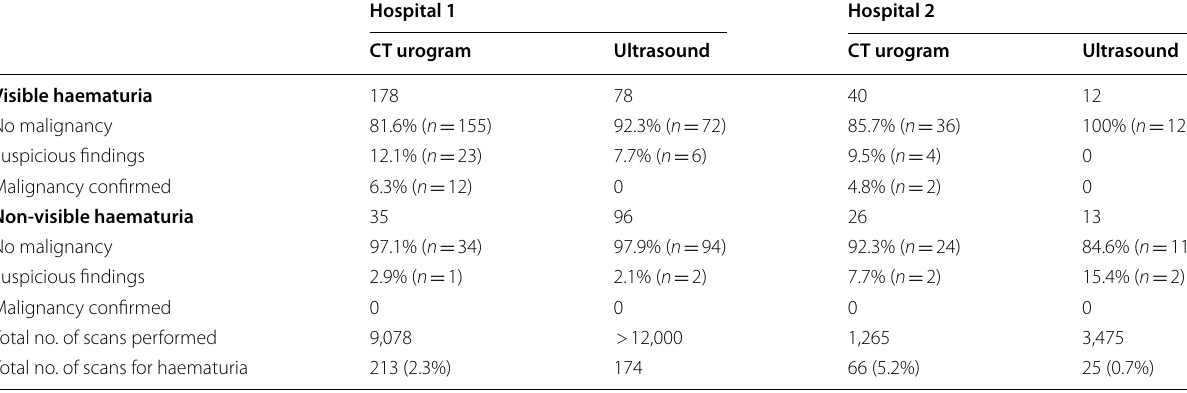
Table 1 Clinical findings based on visible and non-visible haematuria